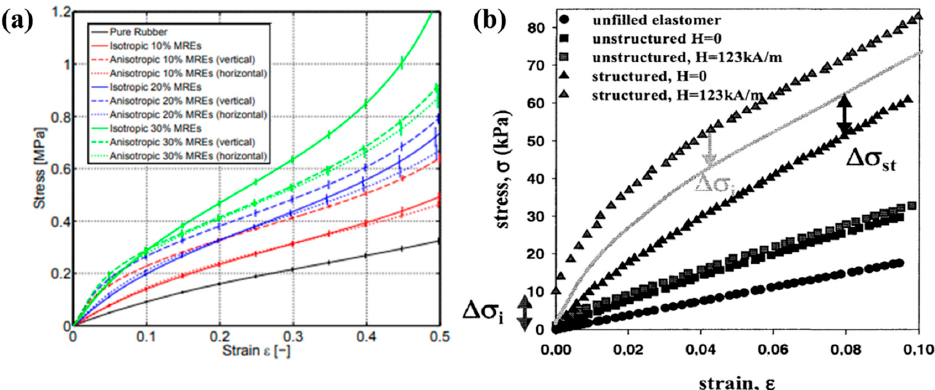
Figure 10. Tensile test results of pure silicone rubber, isotropic and anisotropic MR elastomers with various iron content in the absence of a magnetic field ( a ) (reprinted with permission from [124],